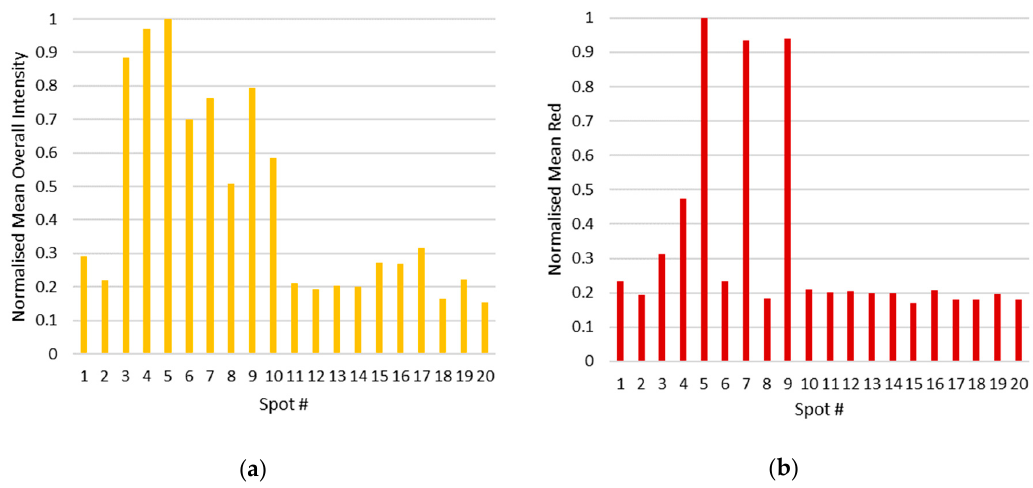
Figure 4. Comparison of the values generated using the RGB histograms (ImageJ) of the multispot inoculation plates (spot numbers correlating to microorganisms listed in Table 2) excited under a 365 nm excitation wavelength: ( a ) normalised mean overall intensity values for each of the 20 bacterial colonies; ( b ) normalized mean red intensity.